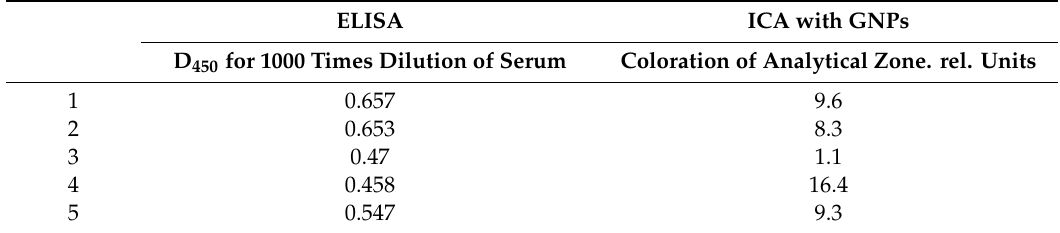
Table A1. Comparison between quantitative values of enzyme-linked immunosorbent assay (ELISA) and immunochromatographic assay (ICA) for 83 tested positive cattle sera. ELISA ICA with GNPs D 450 for 1000 Times Dilution of Serum Coloration of Analytical Zone. rel. Units 0.657